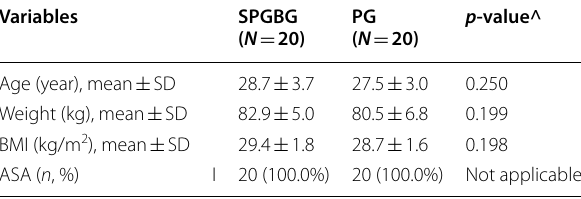
Table 1 Comparison regarding demographic